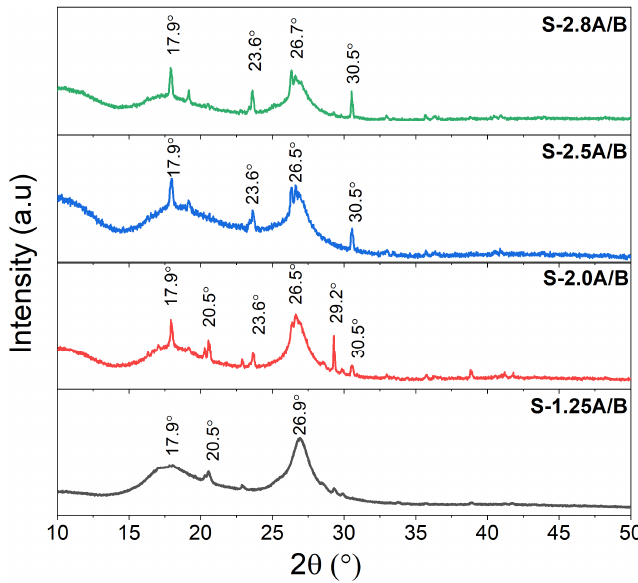
Figure 4. XRD of Pbp samples with different APS/BP molar ratios during synthesis between 1.25 to 2.8 (0.1 M H 2 SO 4 , 1.0 mL DBSA). 2.8 (0.1 M H 2 SO 4 , 1.0 mL